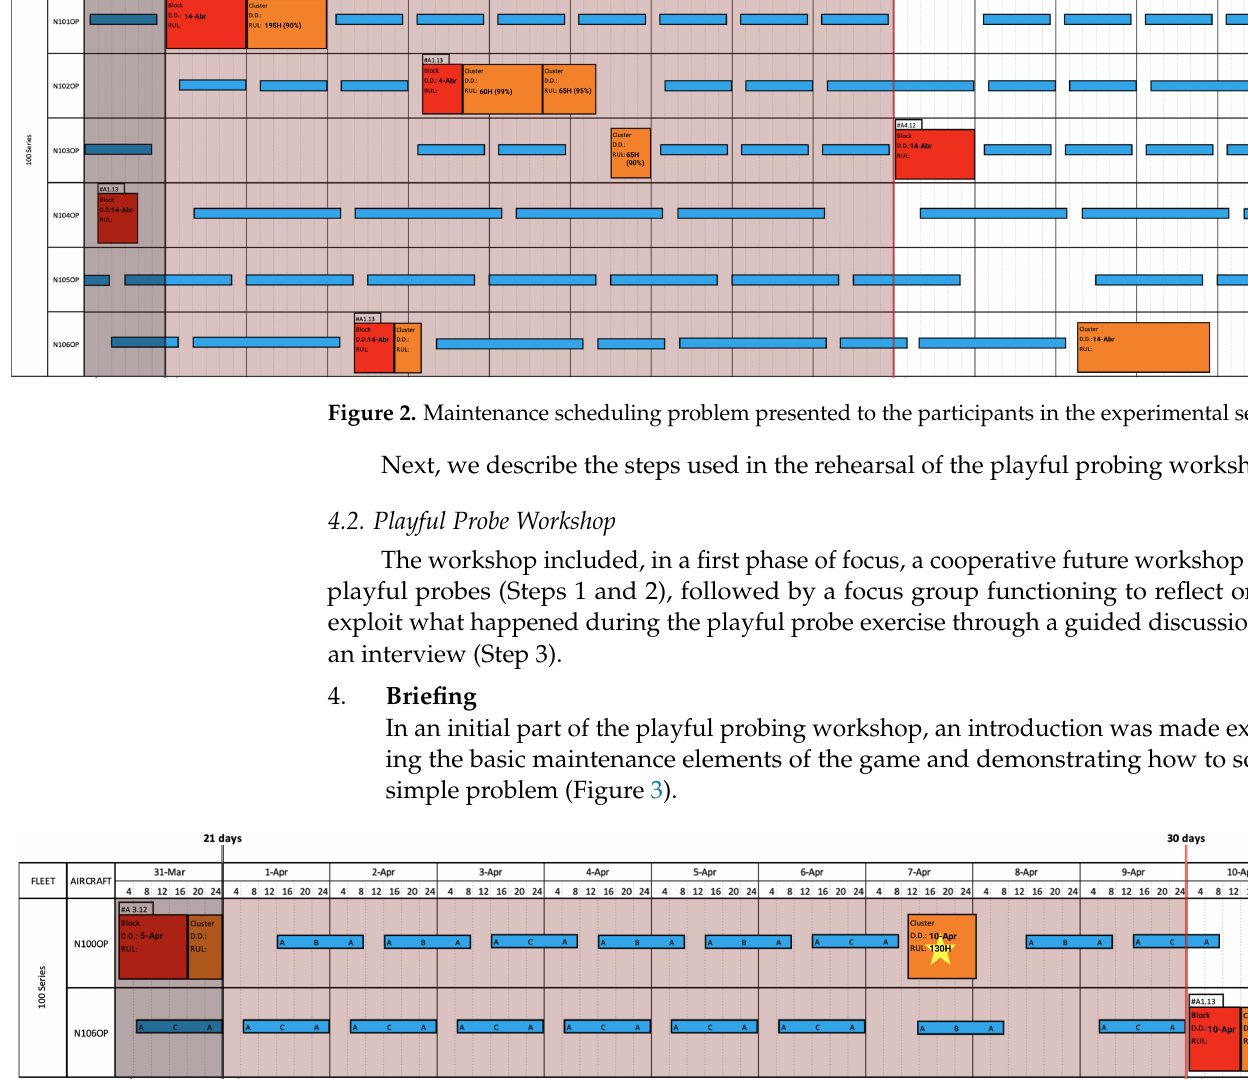
Figure 3. Minimal scheduling problem to introduce the rules and basic movements of the